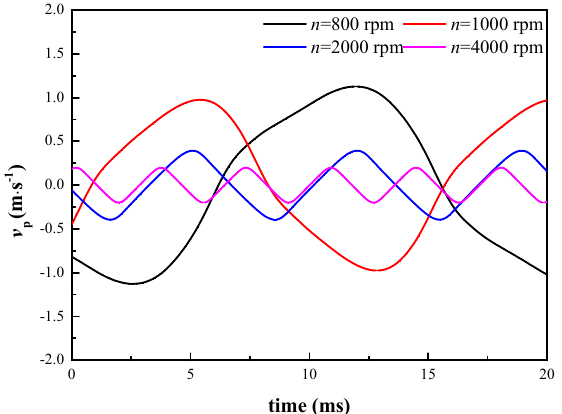
Figure 7. Displacements of different valve spool rotation speeds when the proportional flow control valve port is fully open.